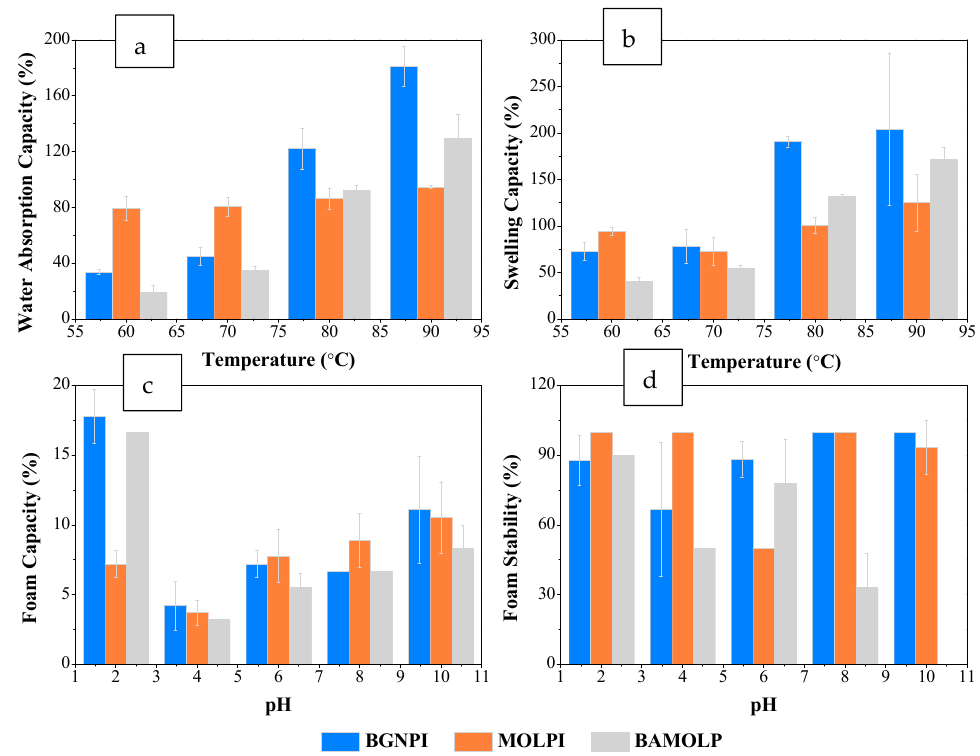
Figure 4. Functional properties of Bambara groundnut protein isolate (BGNPI), Moringa oleifera leaf protein isolate (MOLPI), and BGN and Moringa oleifera leaf protein complex (BAMOLP): ( a ) effect of temperature on water absorption capacity (%); ( b ) effect on swelling capacity (%); ( c ) foam capacity (%); ( d ) foam stability (%). Error bars are the standard deviation of the mean.